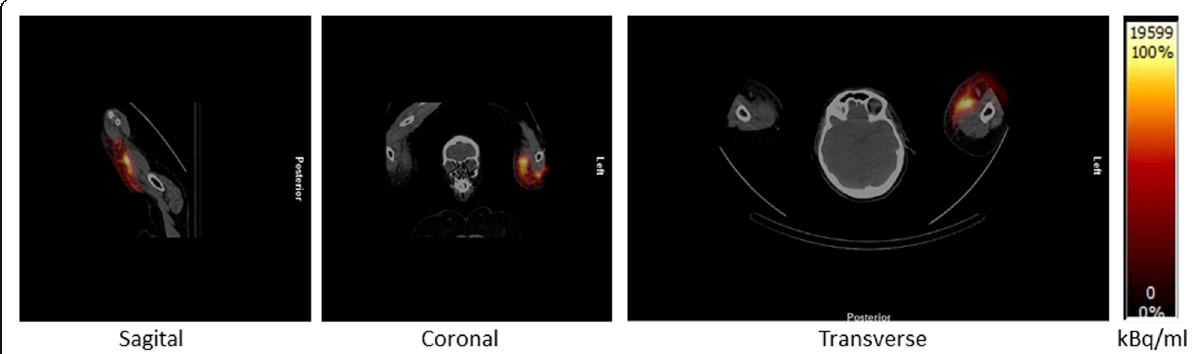
Fig. 2 Distribution of treatment dose in the soft tissue of the arm at the day of treatment